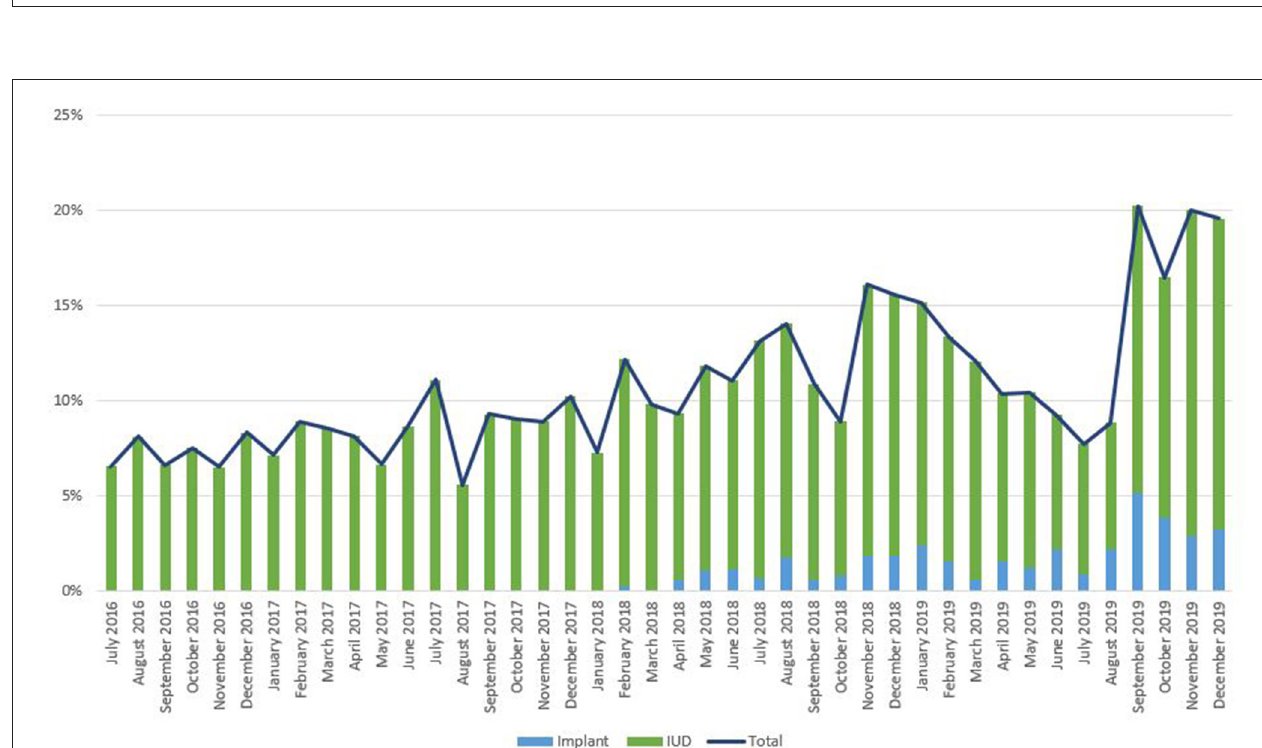
FIGURE 3 | Immediate postpartum IUD and implant uptake among all facility-based deliveries, July 2016-December 2019, DRC.